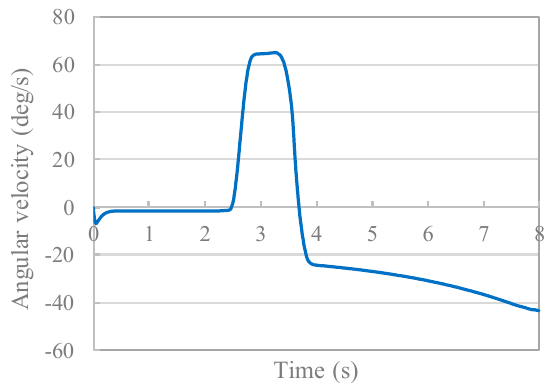
Figure 15. Time history of angular velocity (without control).